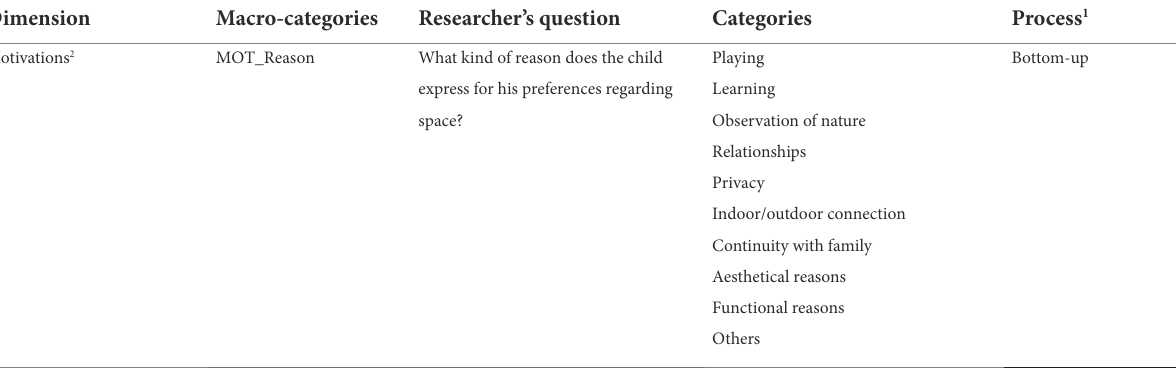
TABLE 5 Motivational dimension: macro-categories and categories included in the DRAW.IN.G. grid.